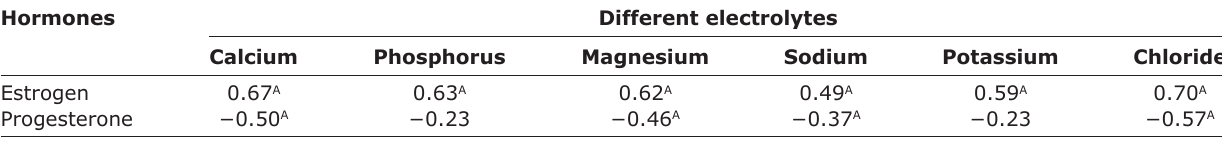
Table-3: Pearson’s correlation coefficients of saliva electrolytes and blood plasma hormones.